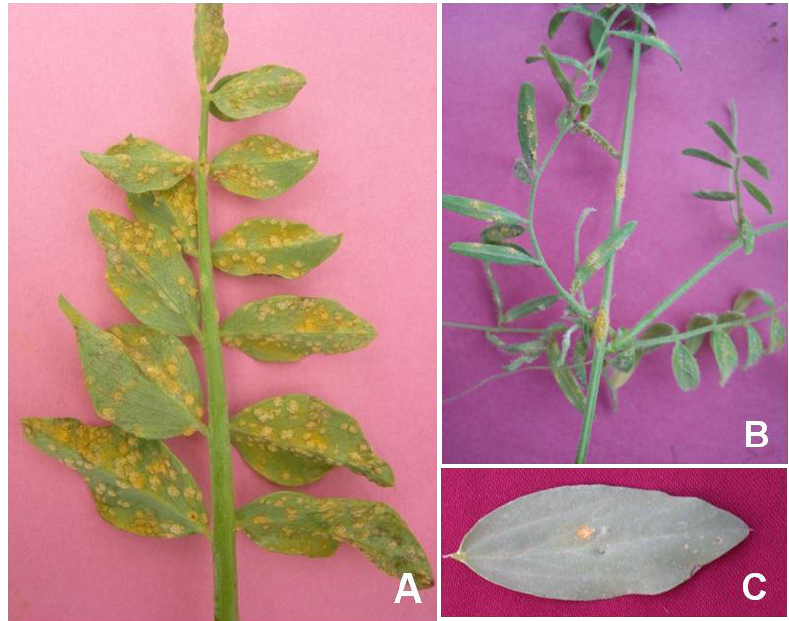
Figure 1. Symptoms of rust caused by U. viciae-fabae on ( A ) Pea, ( B ) Lentil, and ( C ) Faba